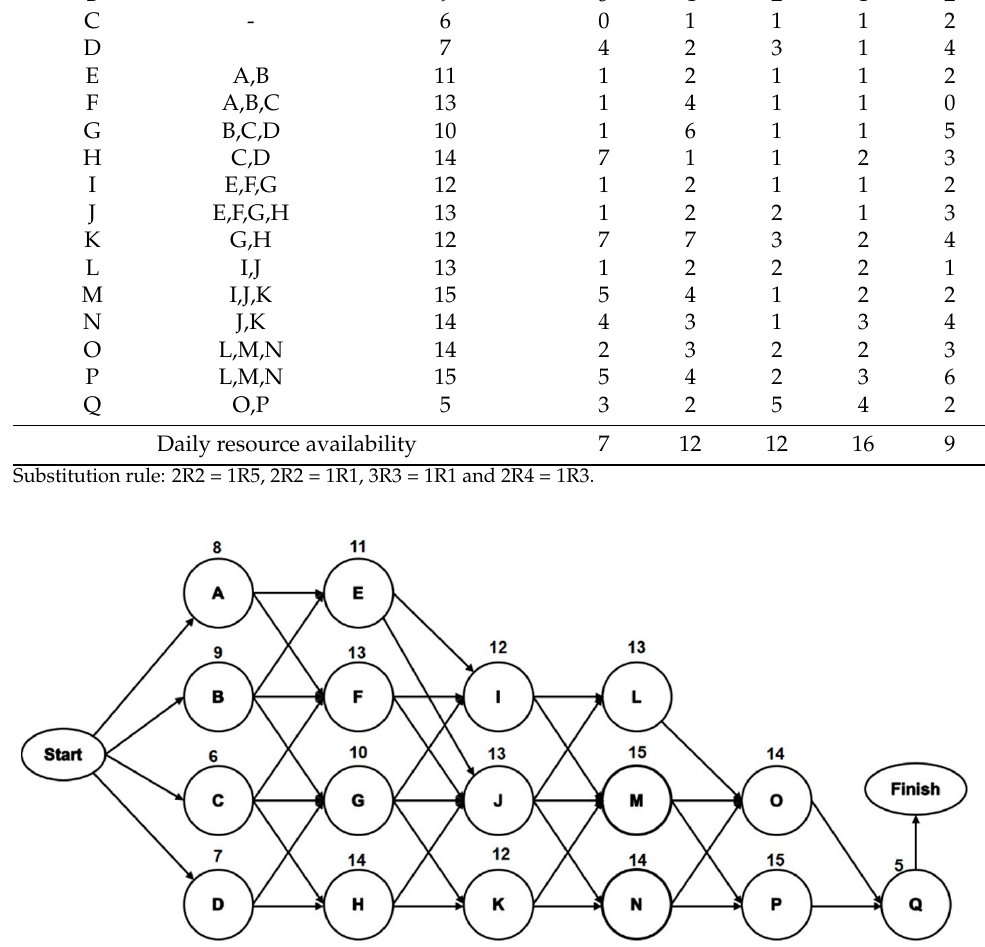
Table 8. Schedule summary.